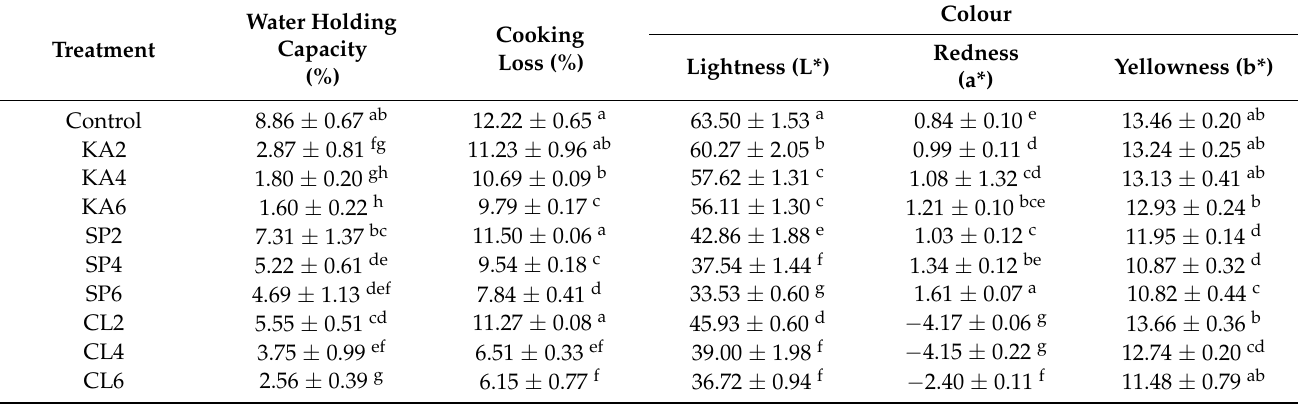
Table 4. Water holding capacity, cooking loss and the colour of the chicken sausage incorporated with seaweed. Treatment